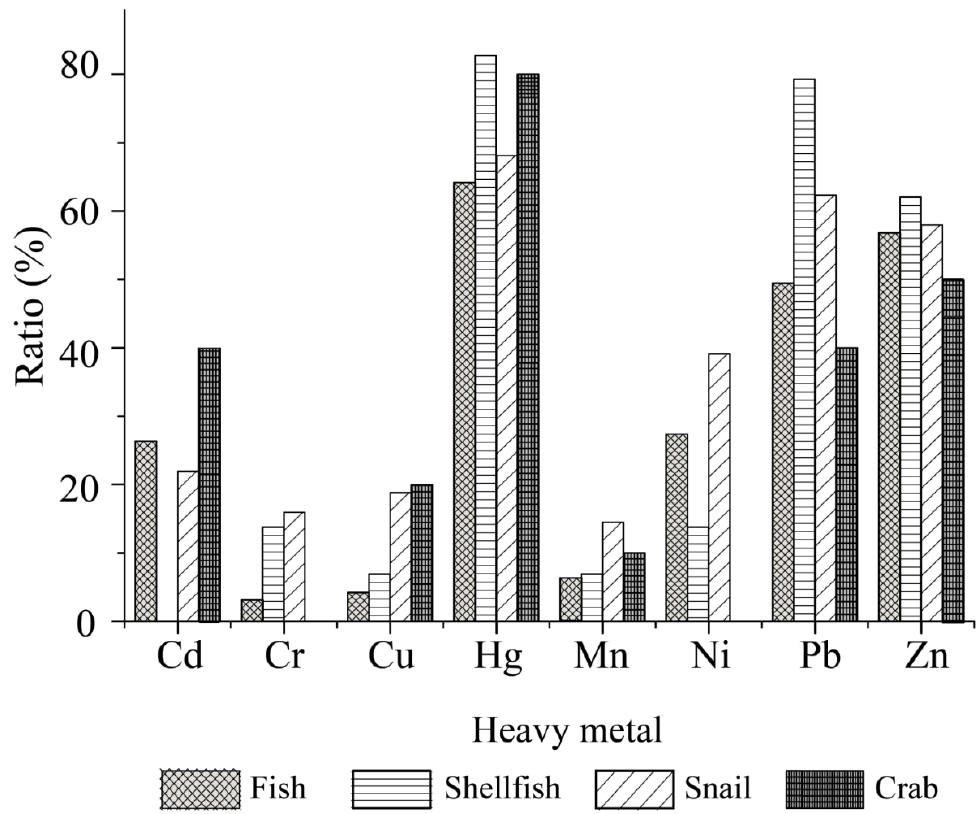
Figure 6. Heavy metal tolerance profiles of the V. cholerae isolates recovered from the four types of aquatic food animals.